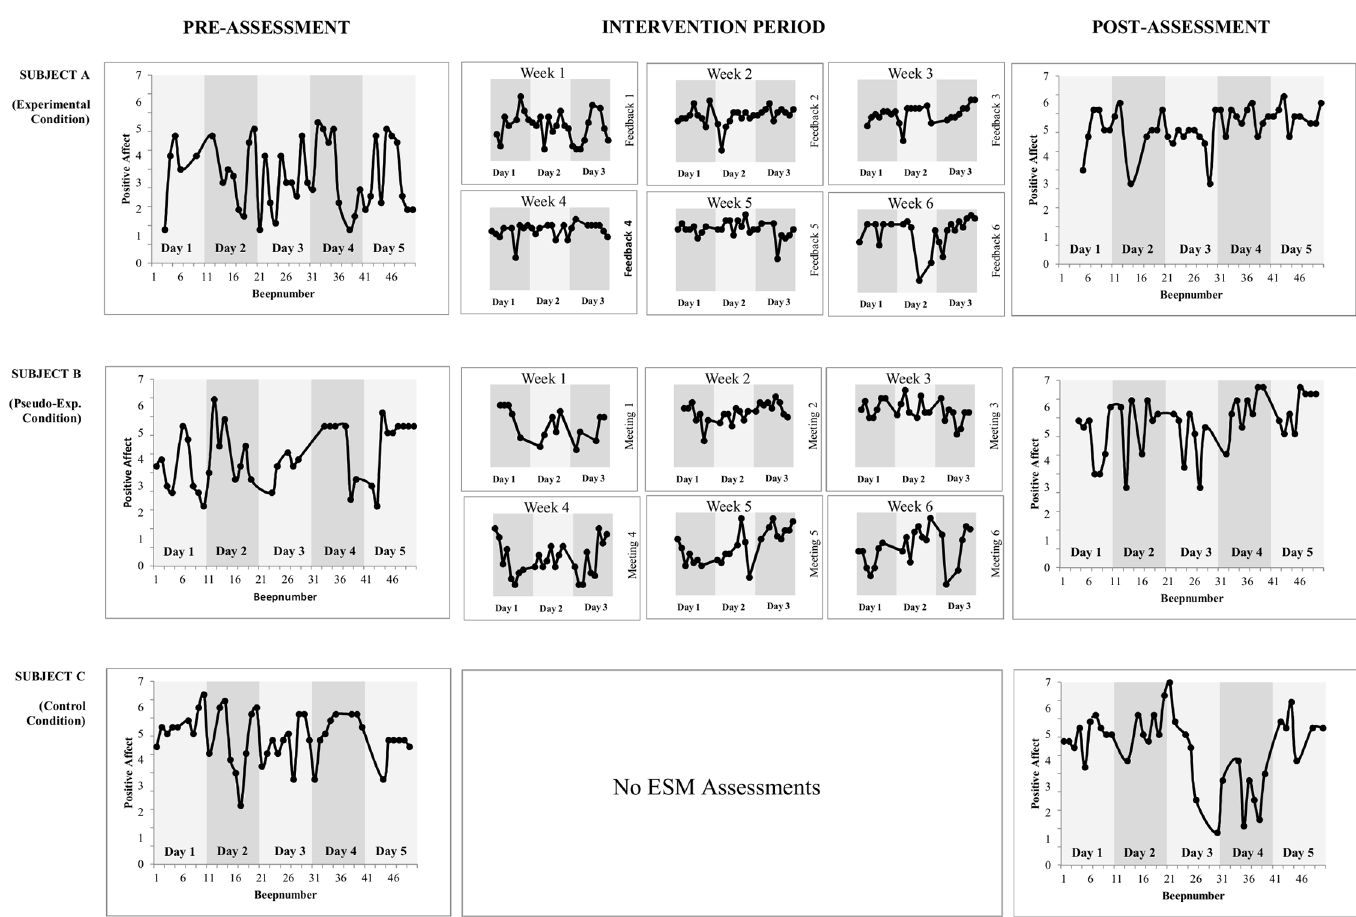
Fig 2. Individual PA series across the study protocol for three participants either randomized into the experimental (subject A), pseudo- experimental (subject B) or control group (subject C). Dots represent the average momentary ratings on the adjectives composing PA (cheerful, enthusiastic, relaxed, satisfied) during one beep. One day comprises ten beeps; pre- and post-assessment comprises five days; the intervention period comprises three days of ESM monitoring per